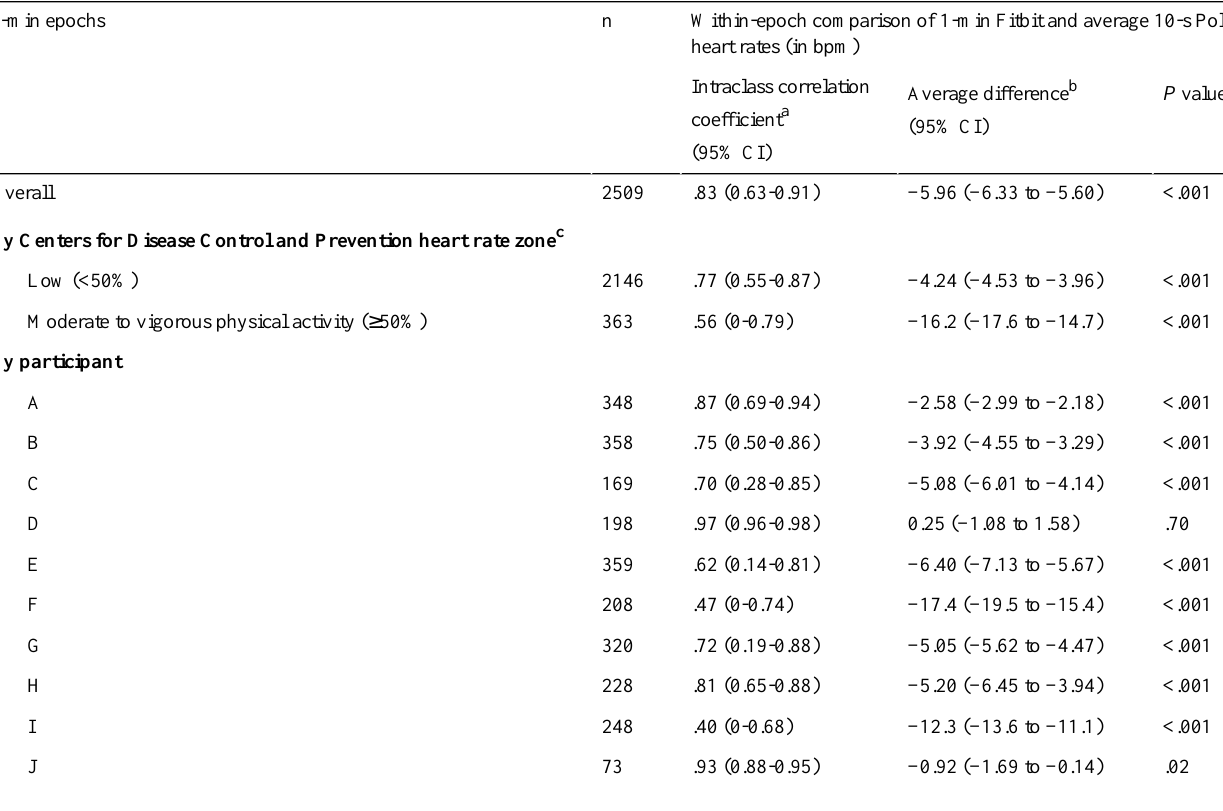
Table 2. Overall and stratified comparisons between Fitbit and Polar of minute-by-minute epochs.